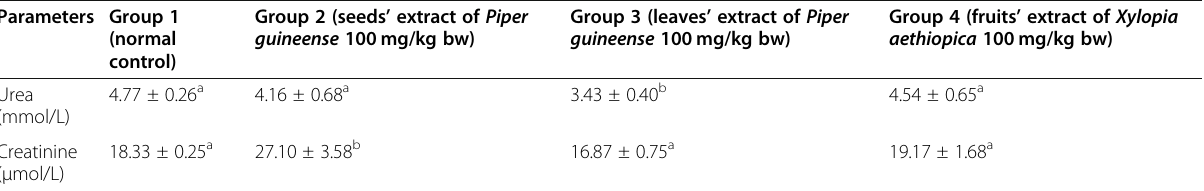
Table 3 Concentrations of urea and creatinine in rats administered ethanolic extracts of fruits of Xylopia aethiopica and seeds and leaves of Piper guineense